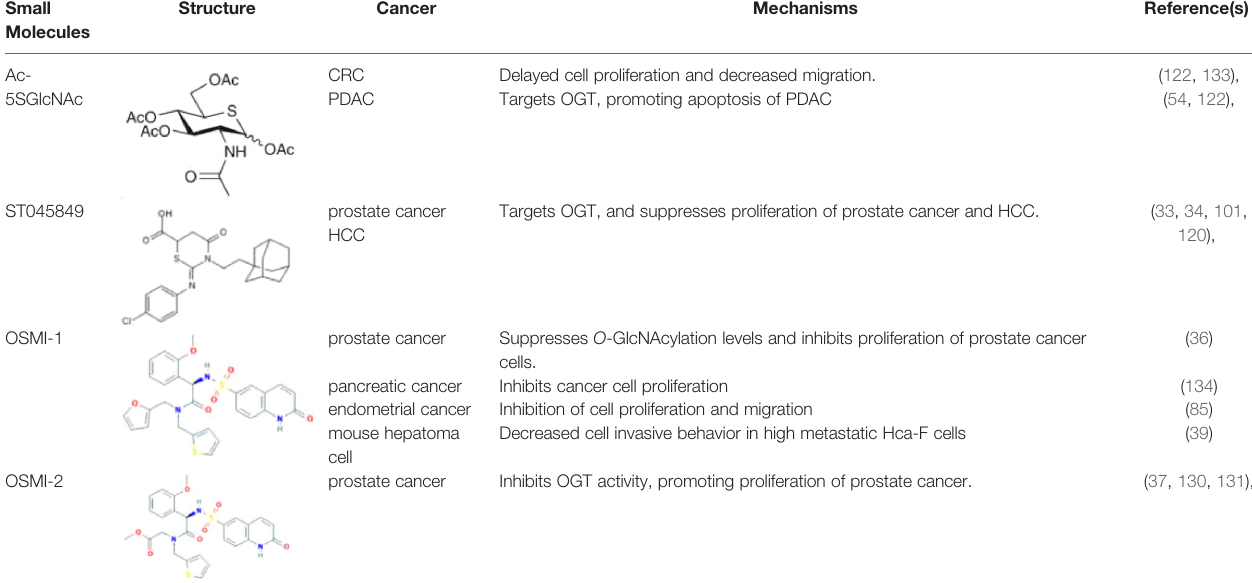
TABLE 2 | Small molecules targeting O -GlcNAcylation in cancer